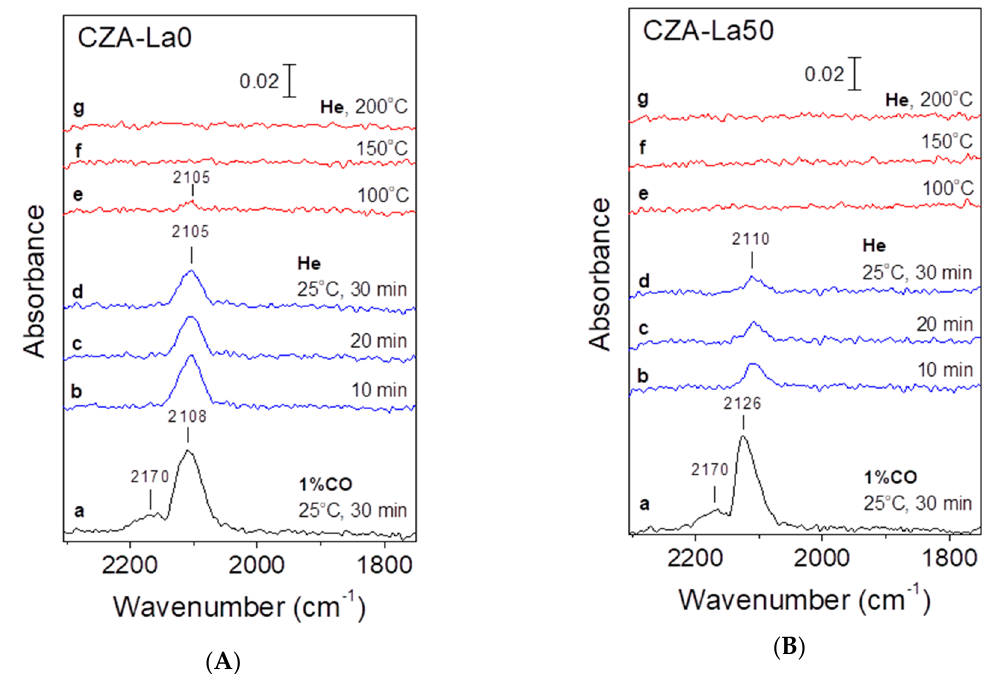
Figure 4. DRIFT spectra obtained over ( A ) the CZA-La0 and ( B ) the CZA-La50 catalyst following interaction with 1% CO (in He) at room temperature (a), purging with He for 30 min (b–d), and subsequent stepwise heating under He flow at temperatures up to 200 °C (e–g).